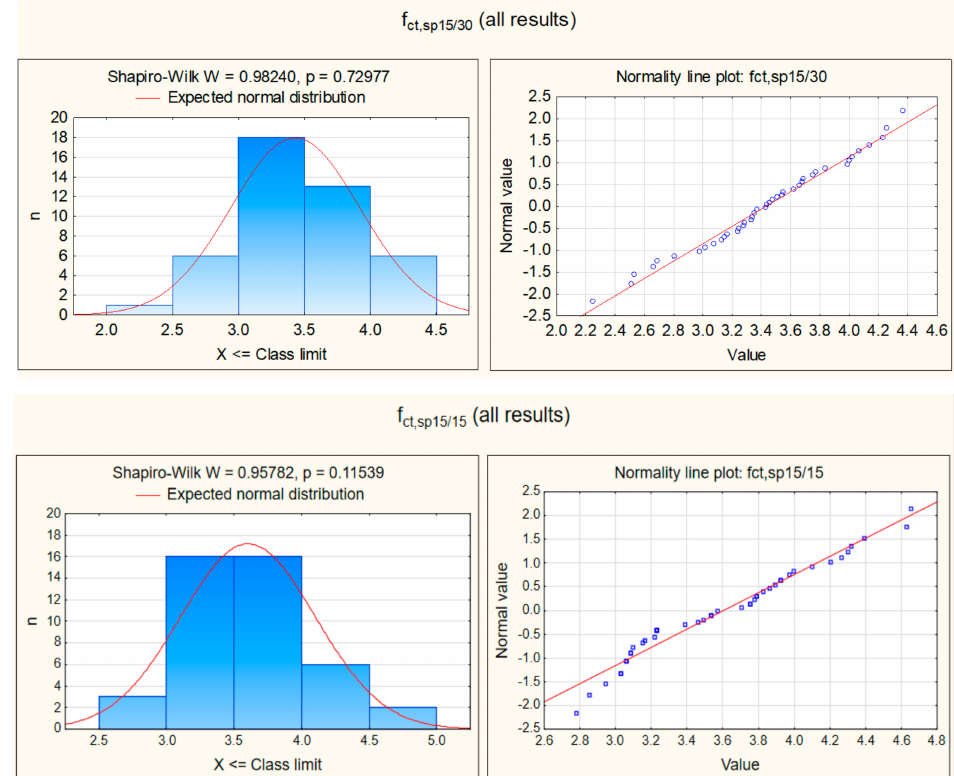
Figure 6. Statistical characteristics of normal distribution for all series taken together, with the results of Shapiro-Wilk